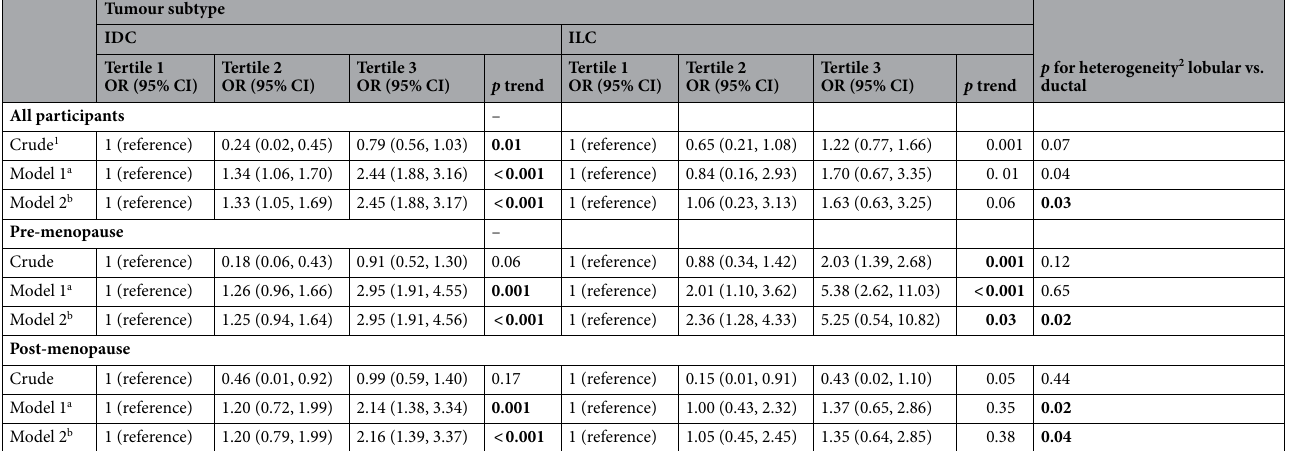
Table 3. Odds ratios (OR) and 95% confidence intervals (CIs) of breast cancer histological subtypes by adherence to the Western diet score (tertiles). IDC invasive ductal carcinoma, ILC invasive lobular carcinoma, OR odds ratio, CI confidence interval. Bolded p-values represent statistically significant associations (Pp < 0.05). 1 Multinomial logistic regression. 2 Using Wald-test of the hypothesis that both subtypes of breast cancer share the same odds ratio for each exposure under study. a Adjusted for energy intake, family history of BC, smoking status, OCP, chest X-ray, history of benign breast disease, BMI, physical activity, age at first delivery (year), breastfeeding (month), history of miscarriage, menarche age (year) and menopausal status. b Adjusted for model 1+ fruit and vegetable